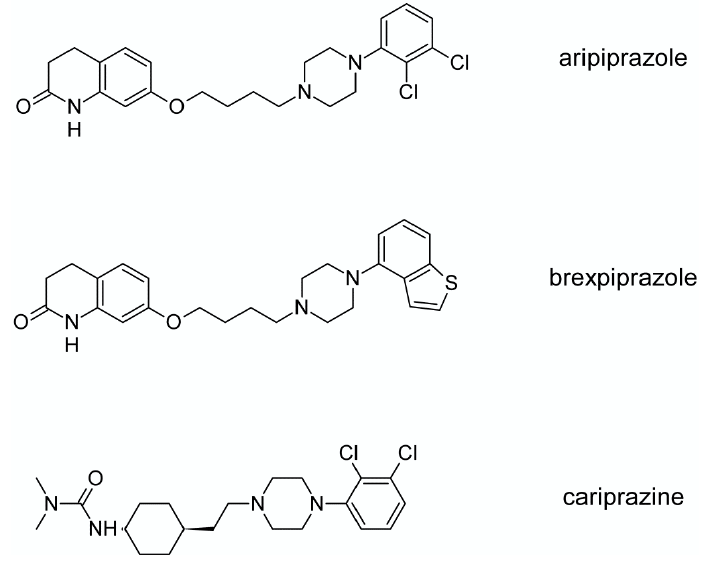
Figure 6. The third generation antipsychotics [1].